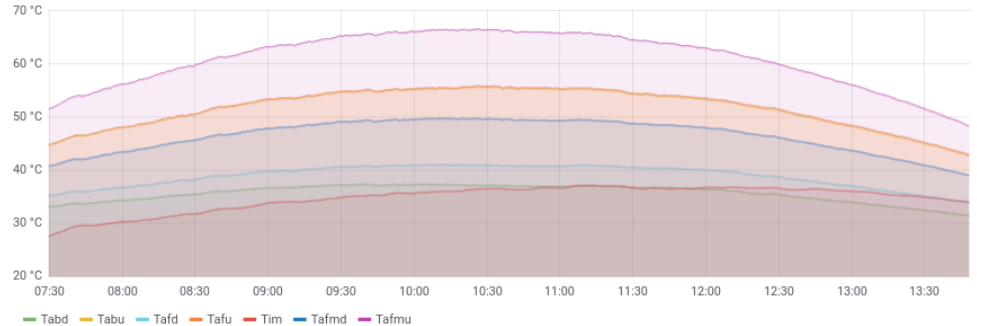
Figure 13. Collector surface temperatures.